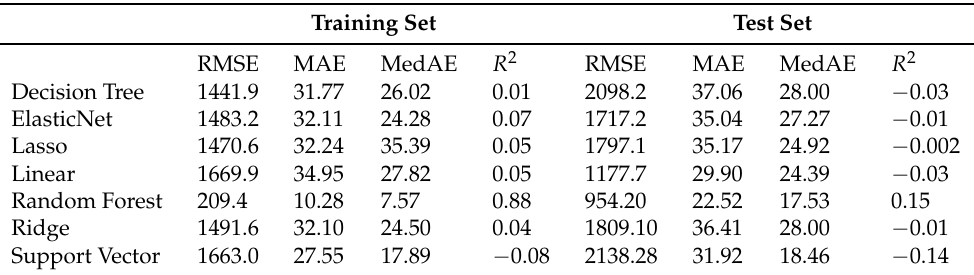
Figure 6. Regression model for dual method—tuning the activation function. Table 5. Other regression models for the execution time of the primal simplex algorithm.